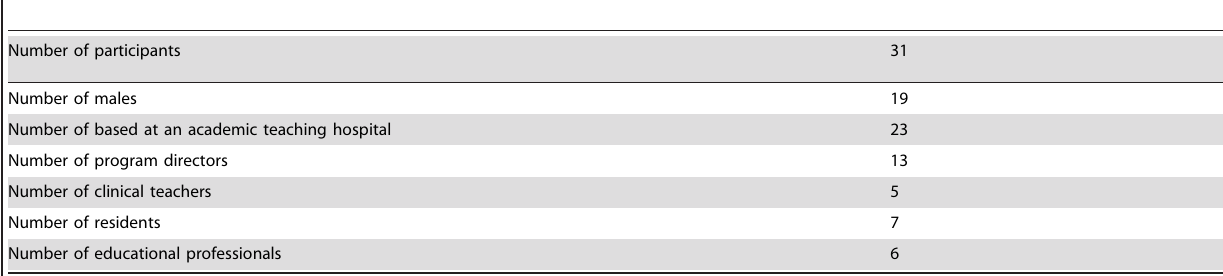
Table 1. Characteristics of the participants in the modified Delphi procedure.